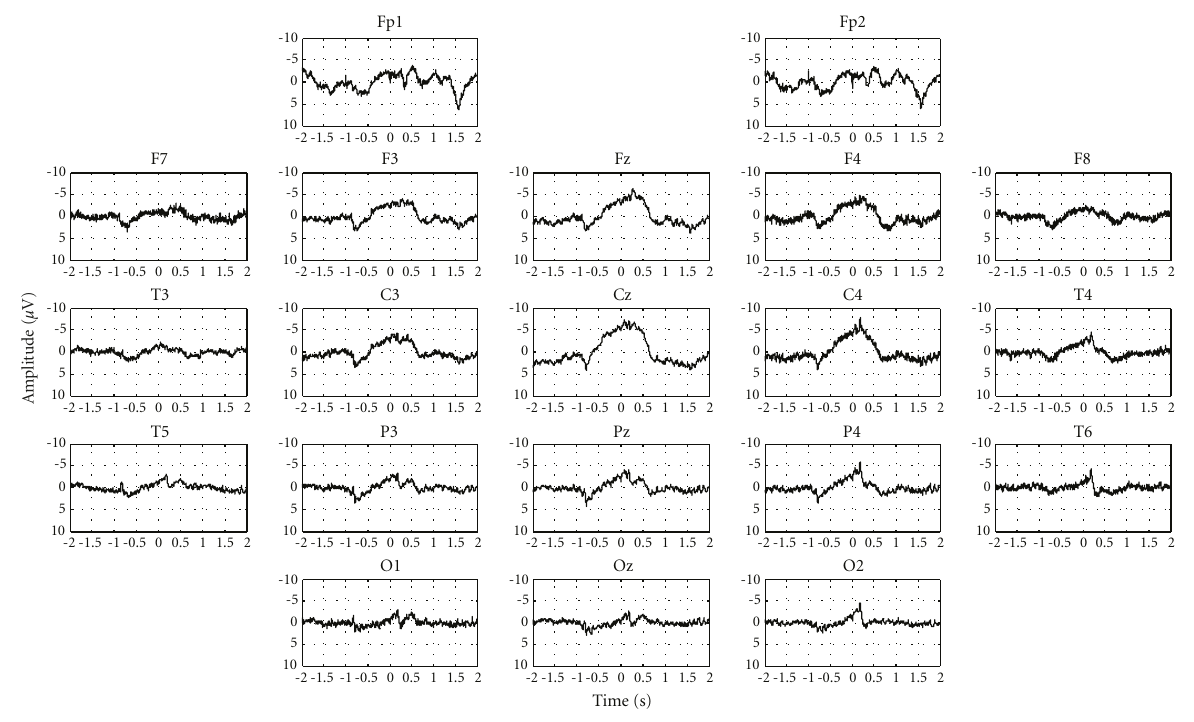
Figure 4: Grand Average topographic distribution of ERPs related to left index finger movement.